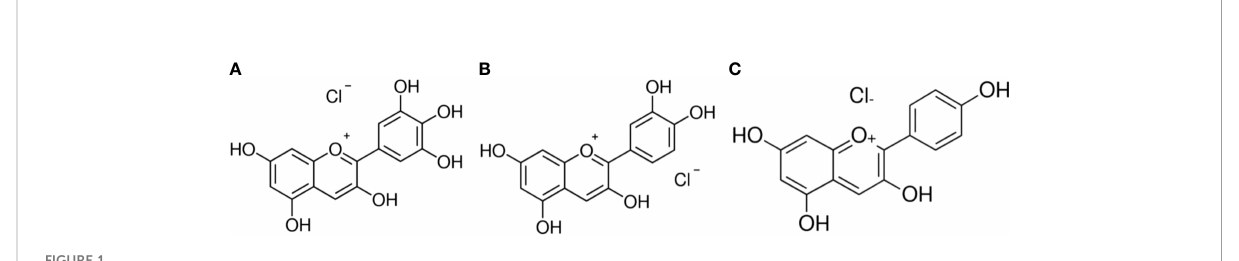
FIGURE 1 Chemical structures (A) Delphinidin (B) Cyanidin (C)